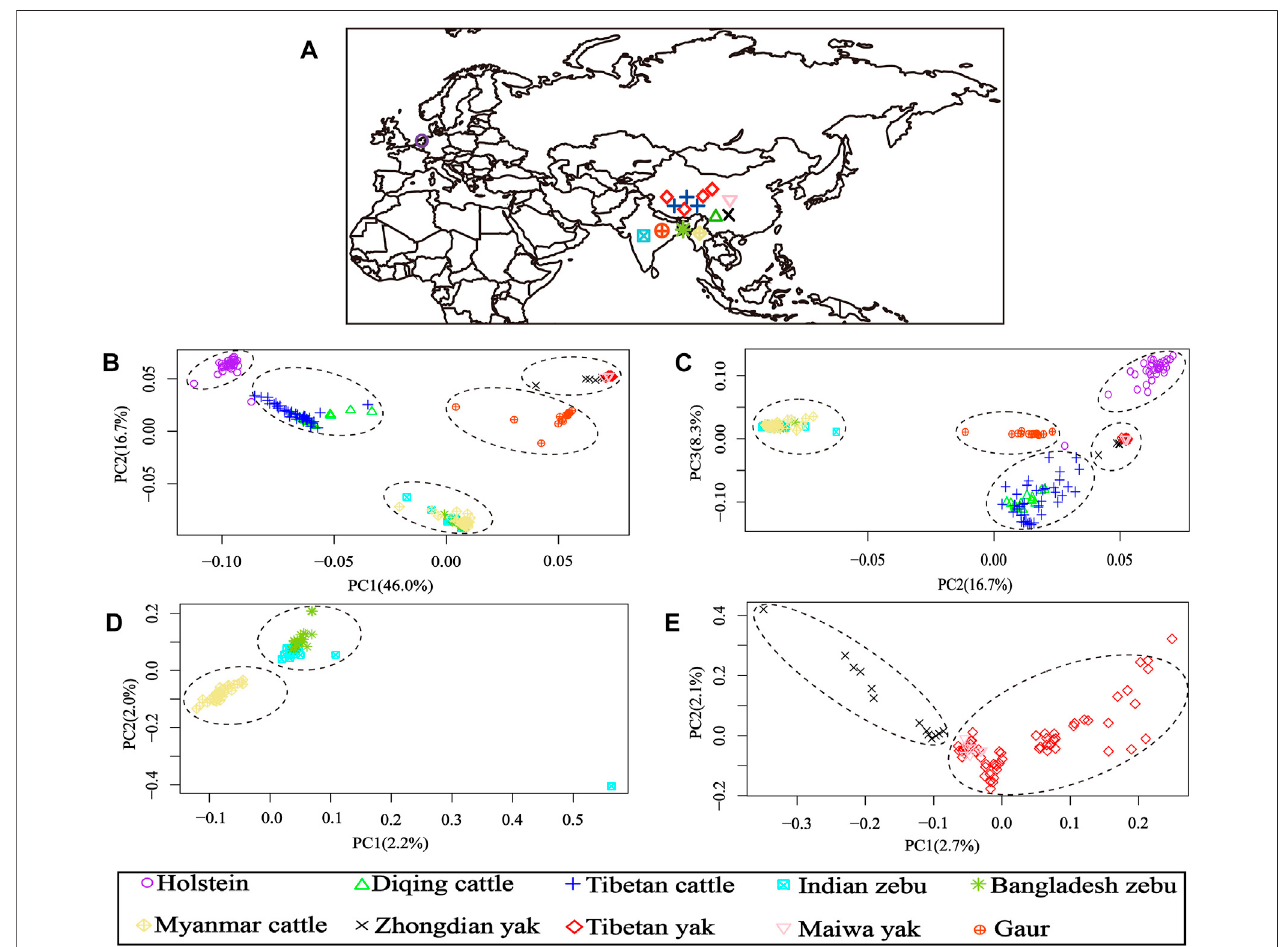
FIGURE 1| Geographicaldistribution and principal component analysis (PCA) results of 10bovinepopulations. (A) Region information of10 populations; (B) PCA resultsofPC1vs.PC2; (C) PCAresultsofPC2vs.PC3; (D) PCAresultsof84samplesfromallzebupopulations(Indianzebu,Bangladeshzebu,andMyanmarcattle); (E) PCA results of 79 samples from all yak populations (Tibetan yak, Zhongdian yak, and Maiwa yak).